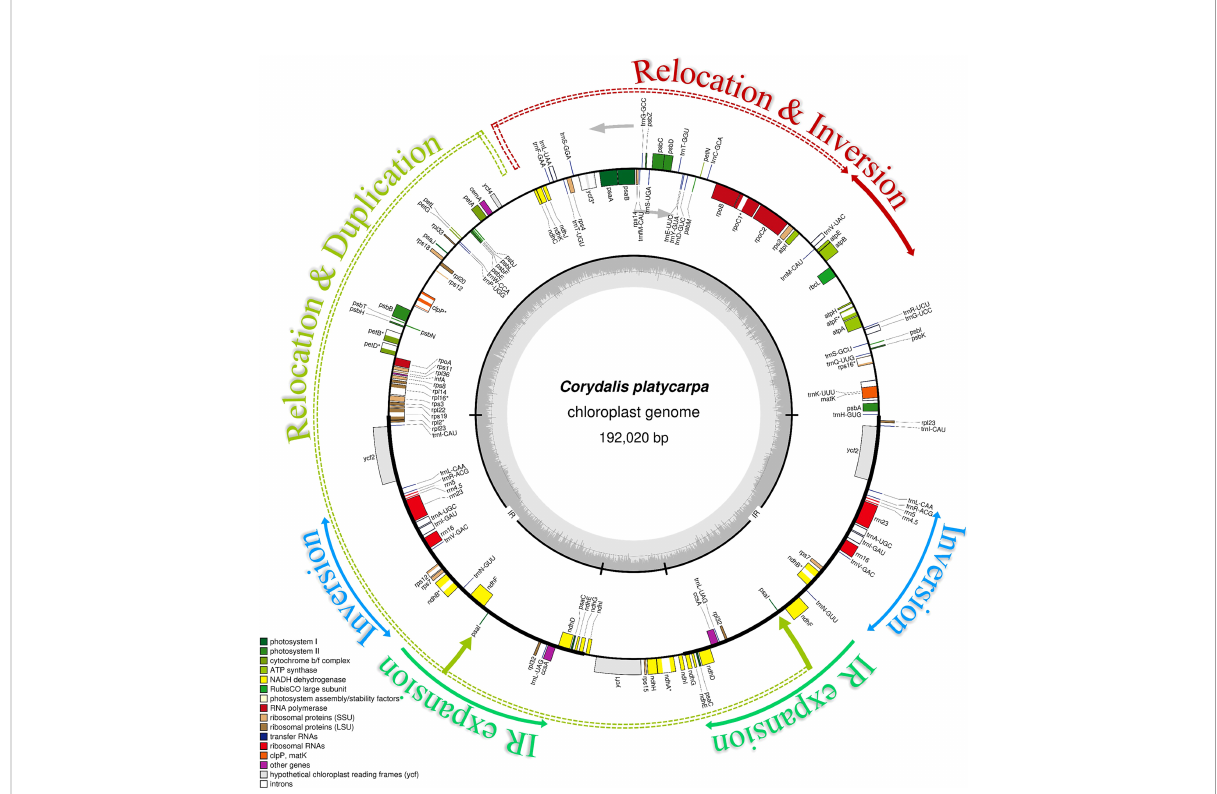
FIGURE 1 Circular chloroplast genome map of Corydalis platycarpa . Genes drawn outside the circle are transcribed clockwise, and those inside are counterclockwise. Genes belonging to different functional groups are color-coded. The darker grey in the inner circle shows the GC content, while the lighter grey shows the AT